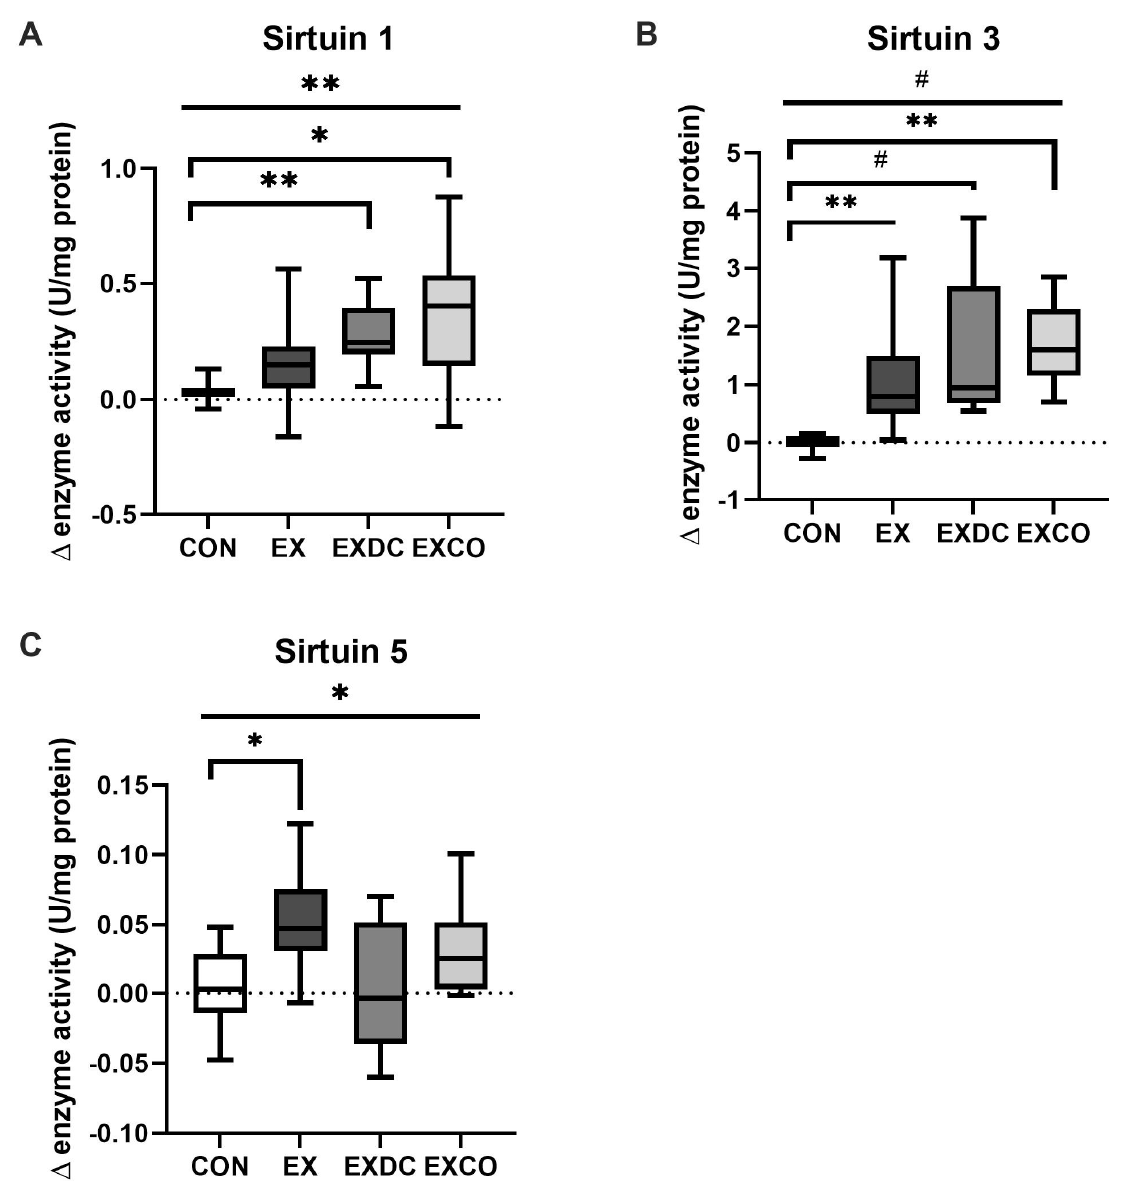
Figure 2. Changes of enzyme capacity (under substrate saturation) of SIRT1, SIRT3 and SIRT5. Changes were calculated as the difference of enzyme capacities after (post) and before (pre) the intervention for the four study groups, CON, EX, EXDC and EXCO, for SIRT1 ( A ), SIRT3 ( B ) and SIRT5 ( C ). Data are shown as median ± quartiles and extremes; n = 8–14. To assess statistical differences a Kruskal–Wallis test was conducted and if significant group differences were detected, a post hoc analysis with Bonferroni correction was performed (* p < 0.05; ** p < 0.01; # p < 0.001).